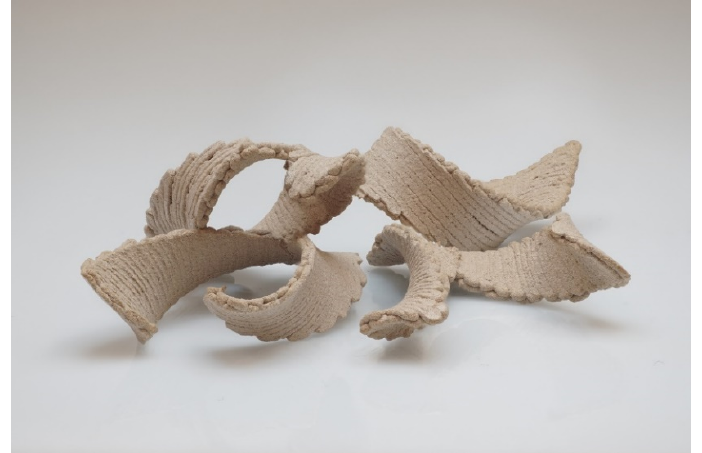
Figure 6. 3D printed wood warped seedpod. These were made by printing to helical ribbons of opposite chirality with a relative angle of 45°.